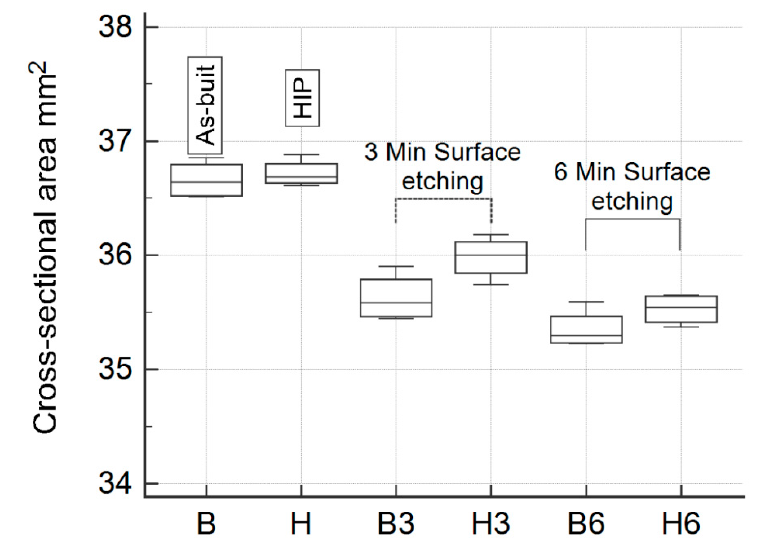
Figure 5. Comparison of the cross-sectional area of porous specimens subjected to various postprocessing methods